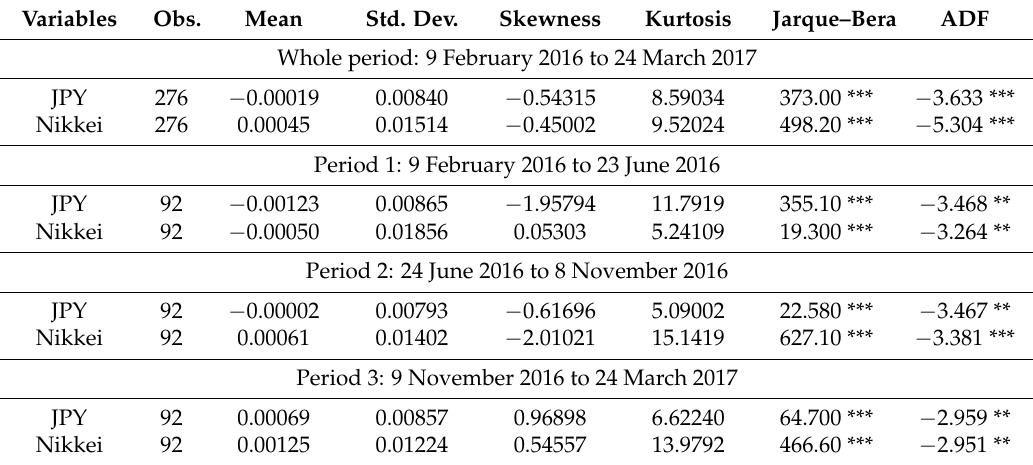
Table 1. Daily logarithmic returns of the nominal exchange rate and stock price. Variables Obs. Mean Std.